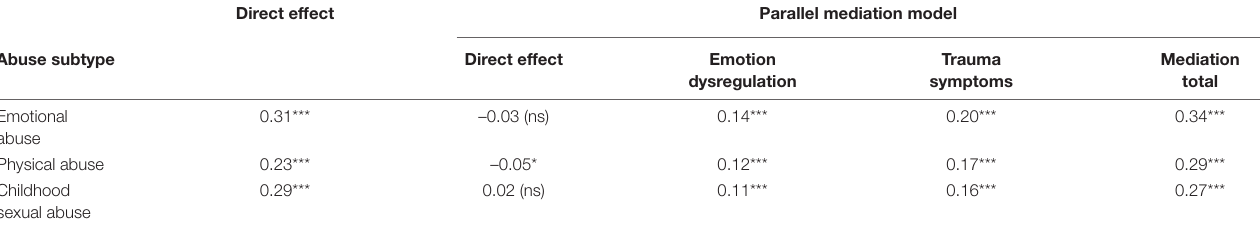
TABLE 4 | Effects with and without parallel mediation (model